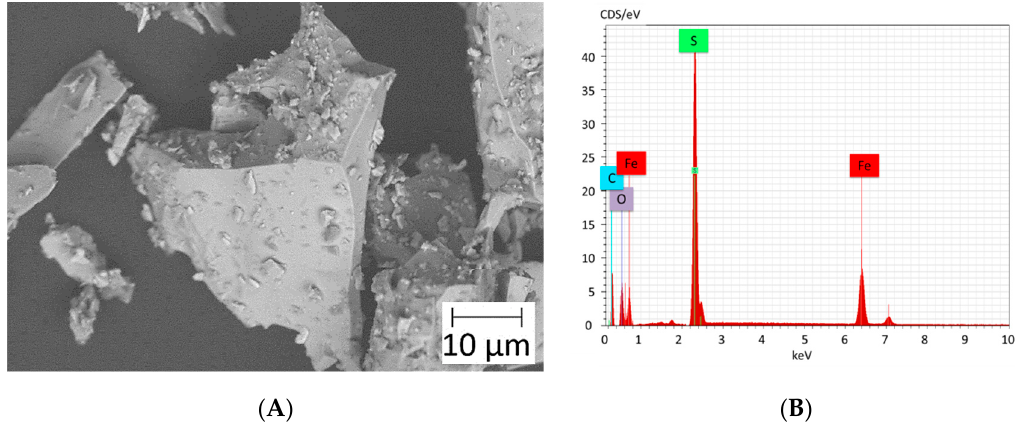
Figure 1. ( A ) SEM micrograph of pyrite sample and ( B ) energy x-ray spectroscopy (EDS) spectrum.